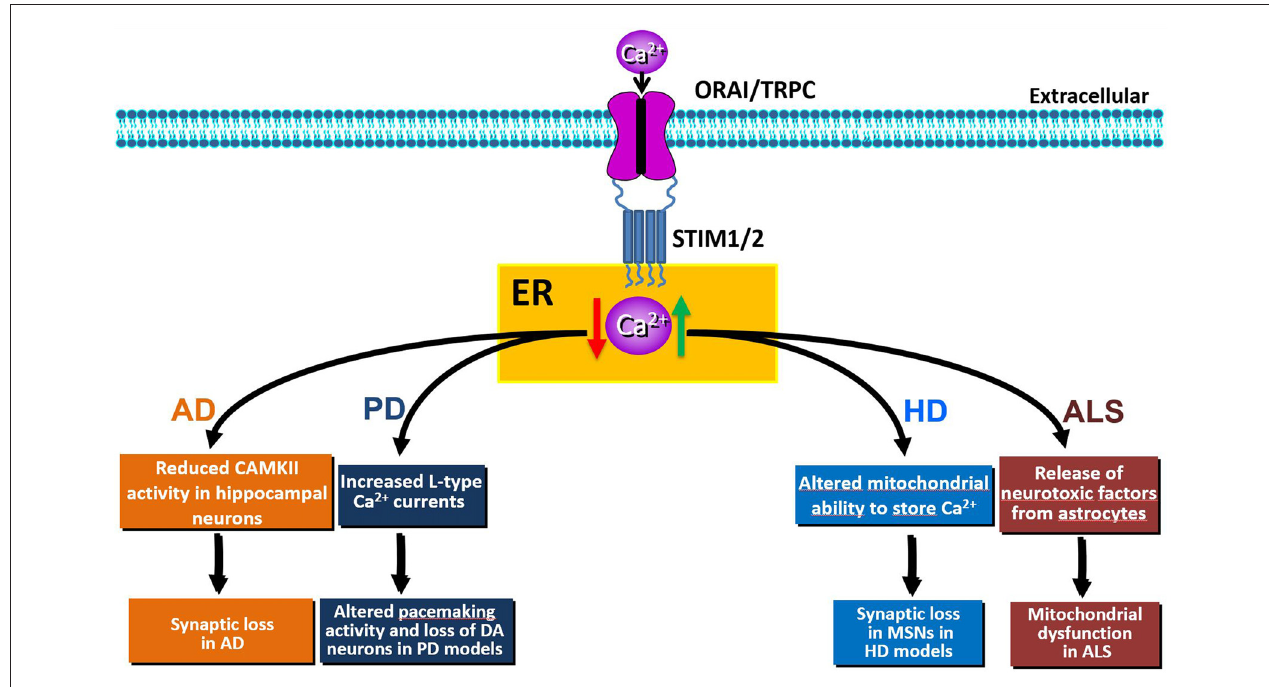
FIGURE 2 | Schematic representation of the effects of SOCE dysfunction (elevation: green arrow or reduction: red arrow) in Alzheimer’s disease (AD), Huntington’s disease (HD), Parkinson’s disease (PD) or amyotrophic lateral sclerosis (ALS) pathobiology.